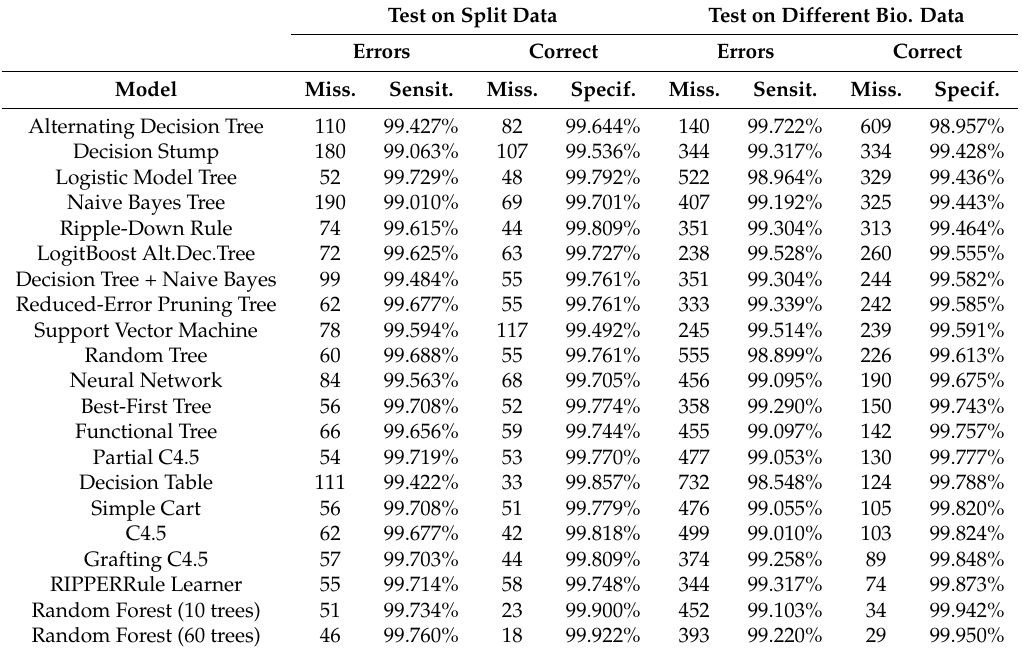
Table 5. Accuracy of error classification in metagenomics using various ML-based